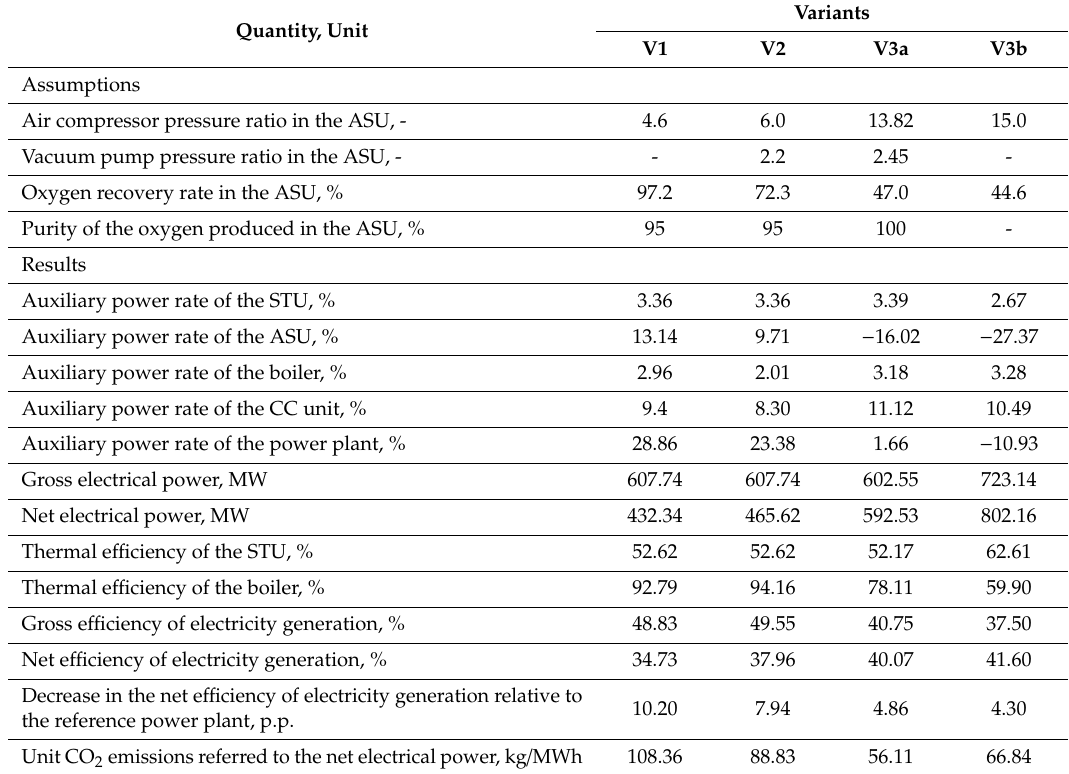
Table 9. Thermodynamic analysis results (waste heat